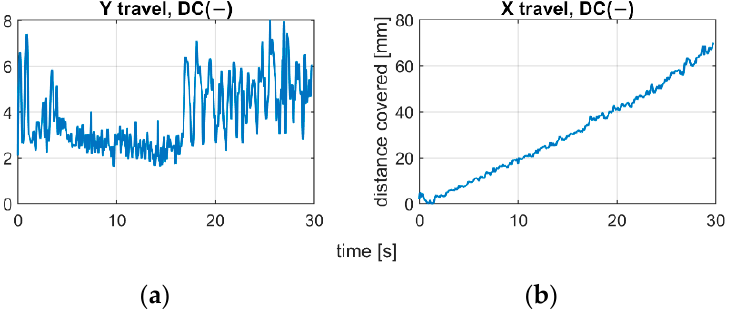
Figure 12. Centroid changes of welding arc ROI in IR image during negative polarity cladding with